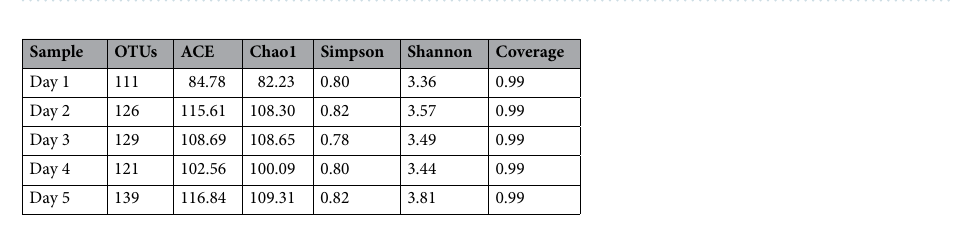
Table 1. Richness and diversity estimates of the 16S rRNA gene libraries from the sequencing analysis.